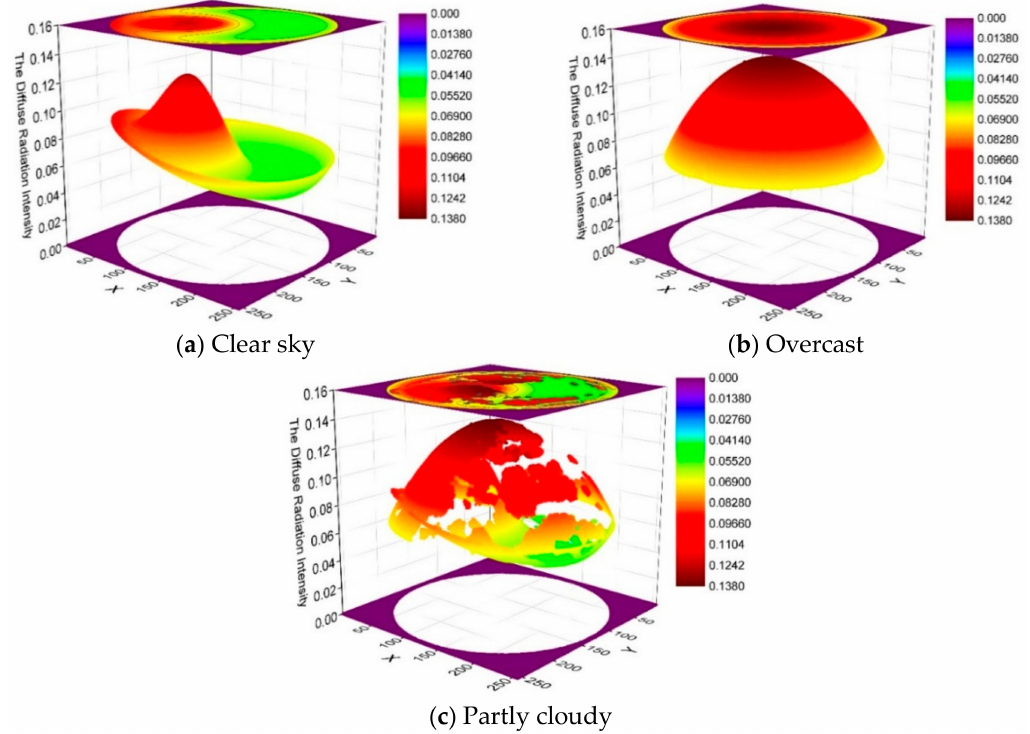
Figure 3. The image-based diffuse radiation intensity fields at 19:37 (UTC) on 7 July